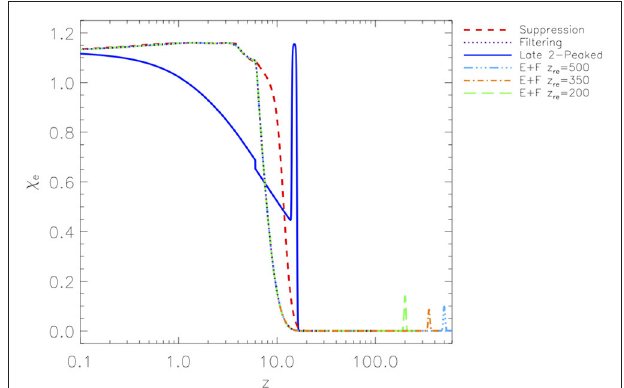
FIGURE 1 | Redshift dependence of the electron ionization fraction for a set of astrophysical and phenomenological reionization histories. For the considered phenomenological models the lower contribution to the global value of τ at z < 10 is compensated by a peaked ionization phase at higher redshift. See also the text. Reprinted from Trombetti and Burigana